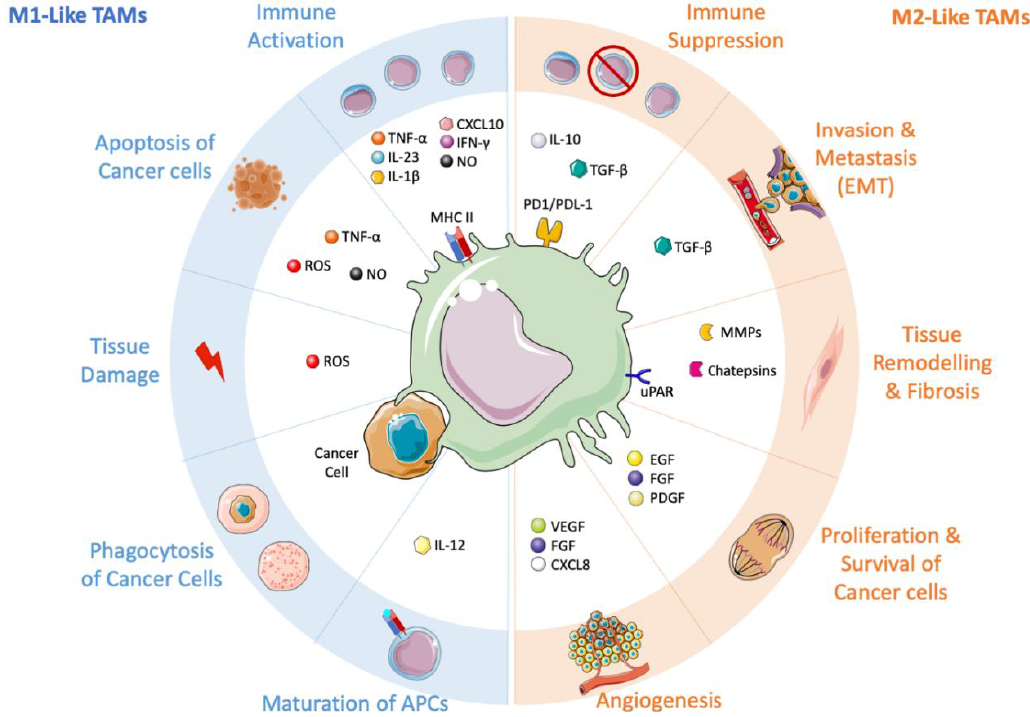
Figure 1. Tumor-associated macrophages (TAMs) and their ambivalent role in shaping the tumor microenvironment. On the left side, the anti-tumoral M1-like macrophages, stimulated by immunostimulatory cytokines (e.g., IL-1 β , IL-12, IL-23, TNF- α , IFN- γ ). M1-like TAMs promote the recruitment and activation of T cells by producing CXCL10, TNF- α , and other cytokines. Through the release of TNF- α , ROS (Reactive Oxign Species), and NO, they can directly kill tumor cells. M1-like macrophages induce tissue damage, maturation of APCs (Antigen Presenting Cell) and they can actively phagocytose cancer cells. On the right side, the pro-tumoral M2-like macrophages, release immuno-suppressive mediators, such as IL-10, TGF- β , IDO1 / 2, which support regulatory T cells. These pro-tumoral immune cells promote tumor proliferation (EGF, FGF, PDGF), angiogenesis (CXCL8, VEGF, FGF), invasion and metastasis (TGF- β ), and a continuous tissue remodeling (MMPs, cathepsins, uPAR).